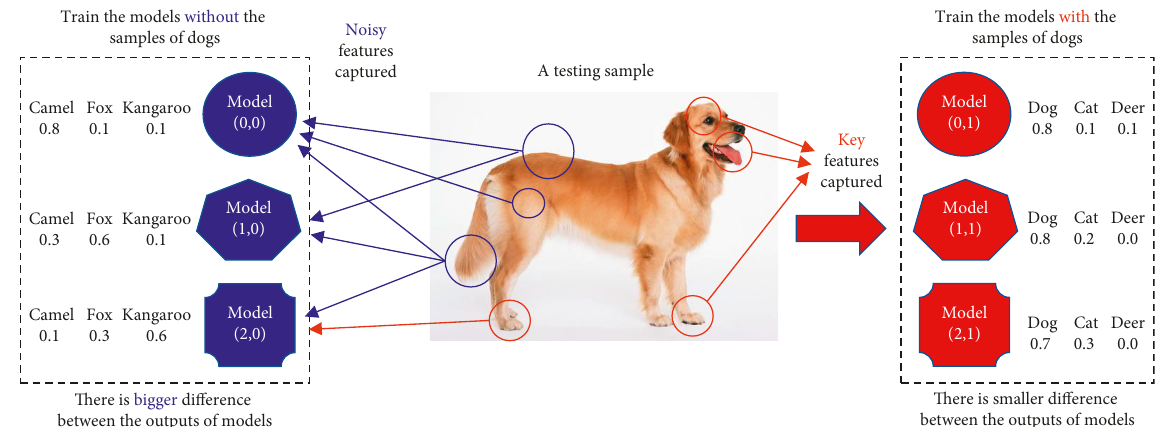
Figure 3: The output of trained models with and without